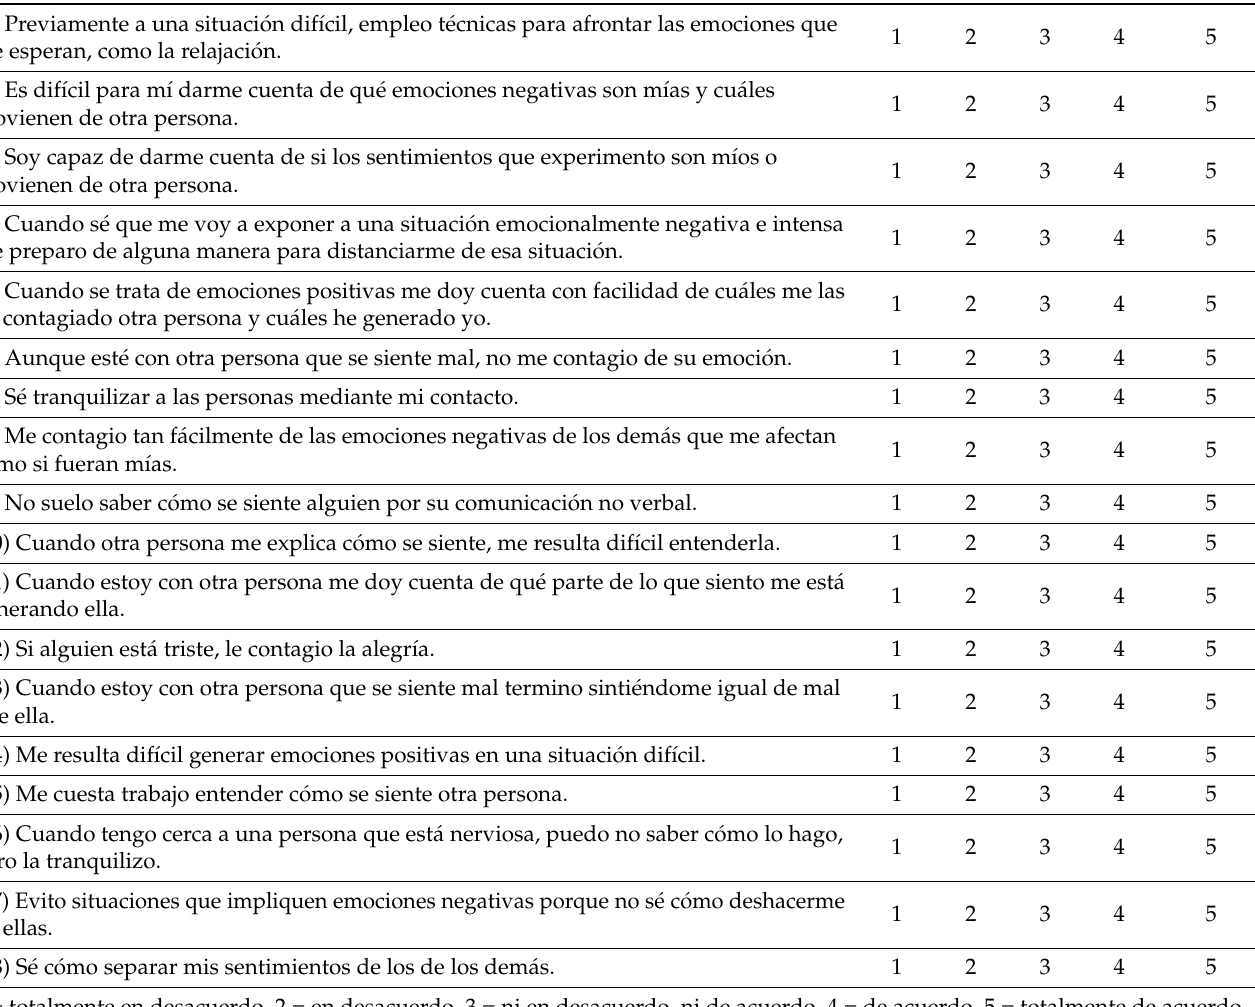
Table A1. Escala de Manejo de Empat í a (EME) in